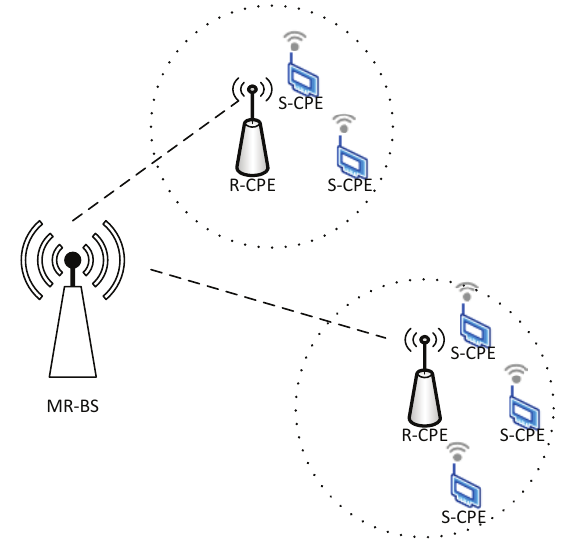
Figure 1. IEEE P802.22b network